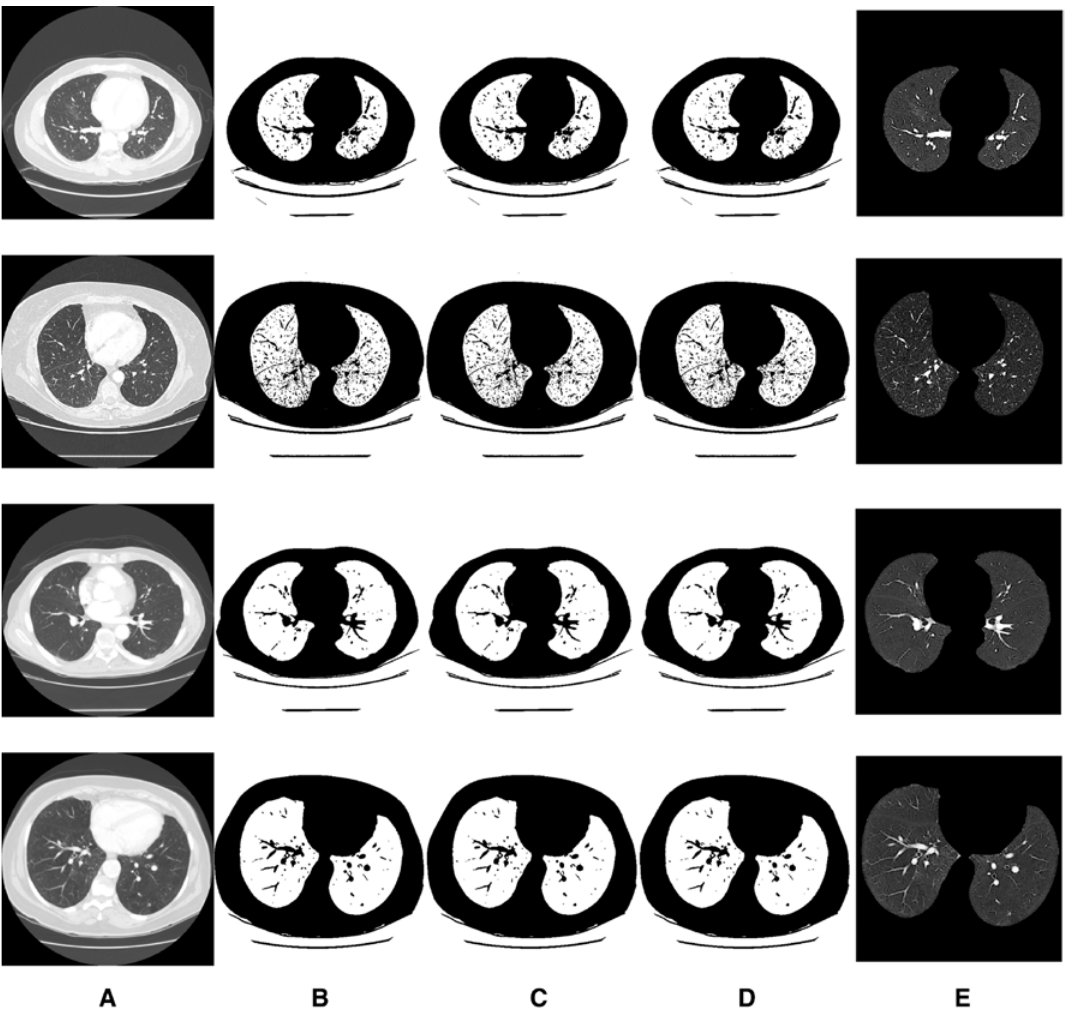
Figure 3: Segmentation of lung parenchyma in thoracic CT image using optimization techniques. (A) CT images (CT-1,2,3,4). (B) Lung segmentation done by 2D Otsu optimized by PSO. (C) Lung segmentation done by 2D Otsu optimized by DPSO. (D) Lung segmentation done by 2D Otsu optimized by FODPSO. (E) Enhanced resultant image of